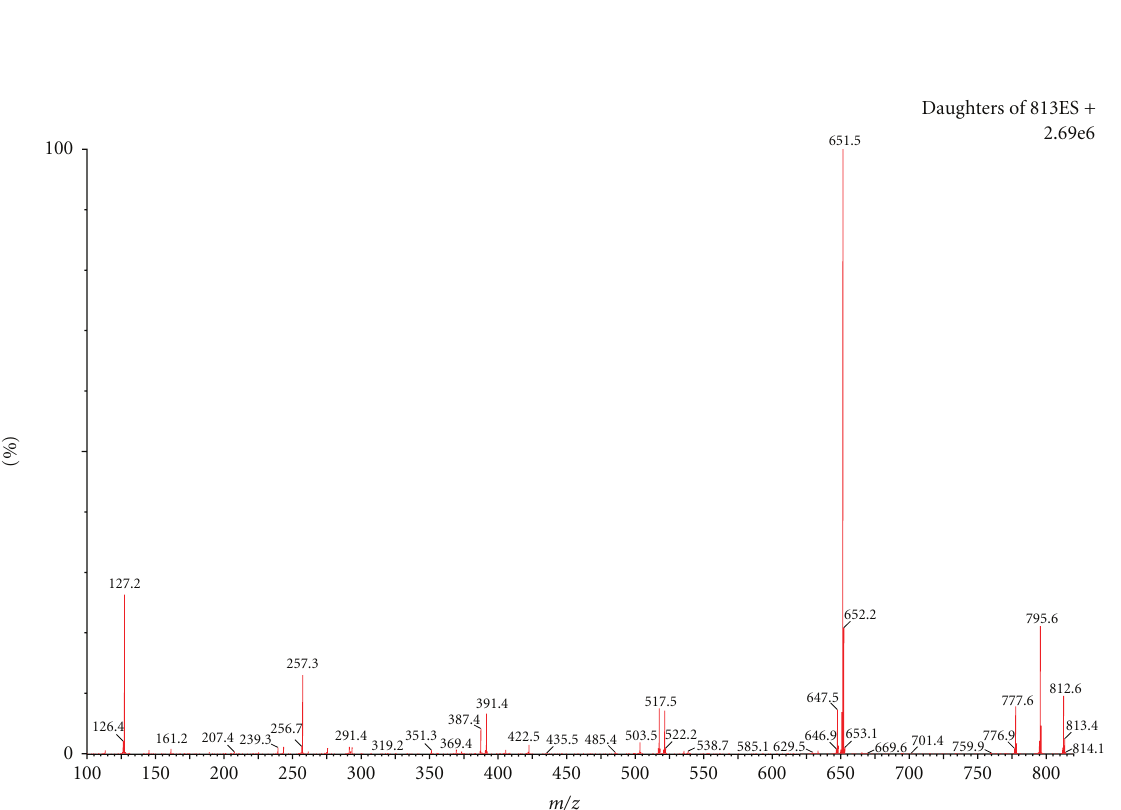
Figure 5: Product ion mass spectra of